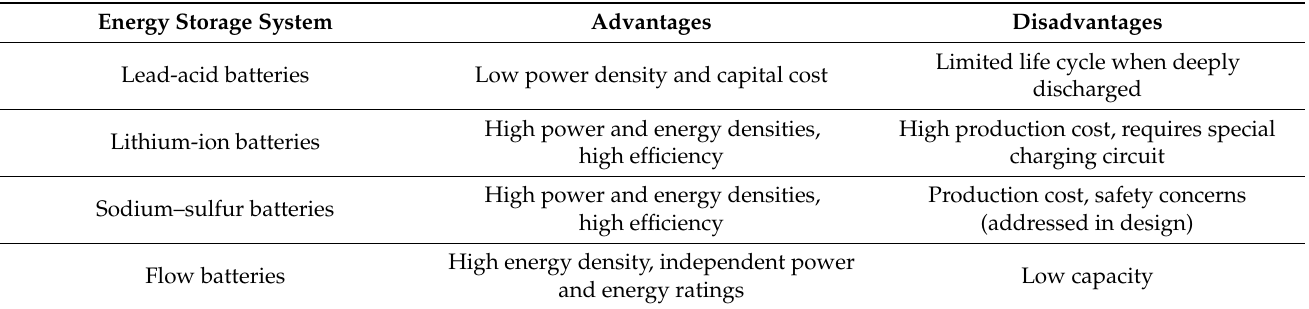
Table 3. Main battery technologies used in large-scale applications. Adapted from [3]. Energy Storage